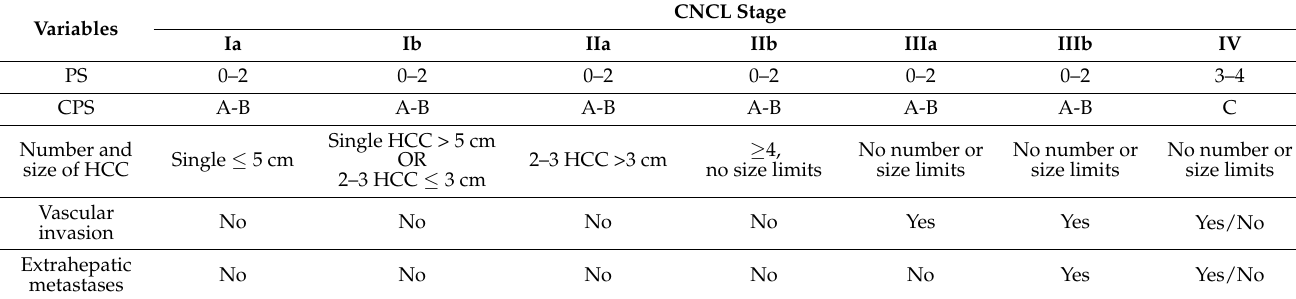
Table 3. HCC staging according to CNCL staging system (2019 version)